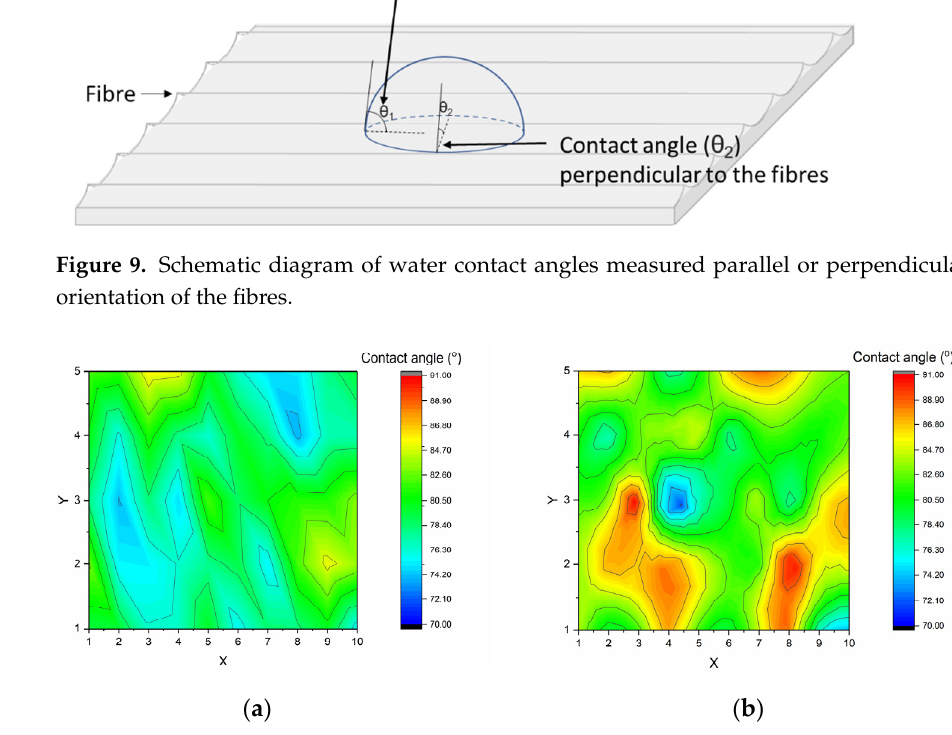
Figure 10. Contact angles distribution represented by different colours on the untreated sample (5 × 10 cm 2 ) when measured at different fibre orientations: ( a ) parallel, ( b ) perpendicular to the fibres.